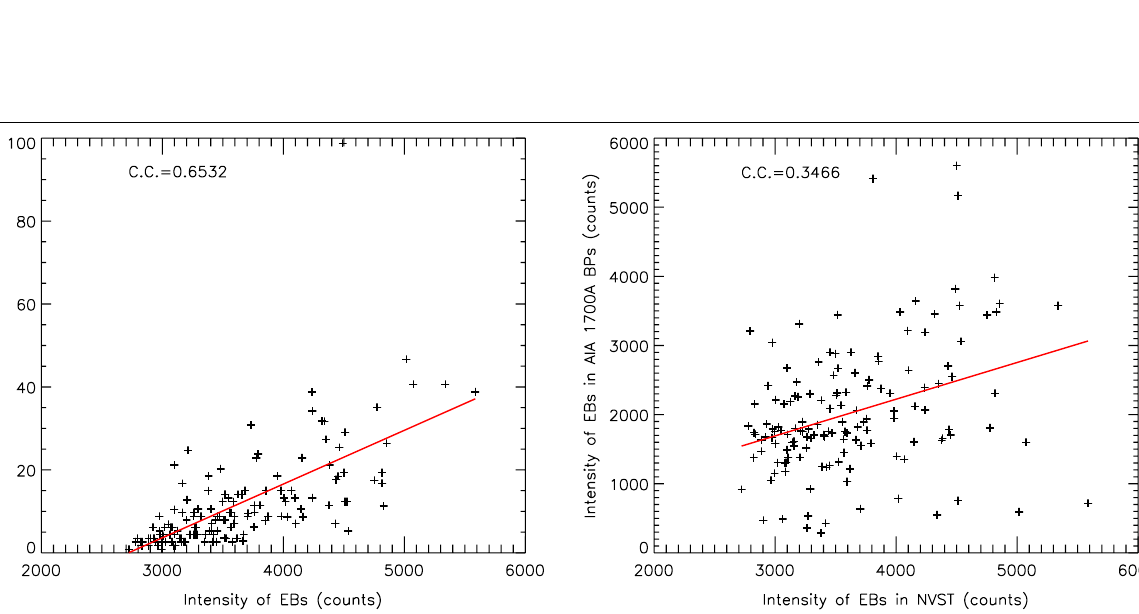
Fig. 3 Left panel: scatter plot depicting the relationship between the intensity and lifetime of EBs identified from the H α wing images. Right panel: scatter plot depicting the relationship between EB intensity in H α wing and AIA 1700 Å images. Each red diamond represents the average 1700 Å intensity in each bin of H α wing intensity. Red lines represent the results from a linear